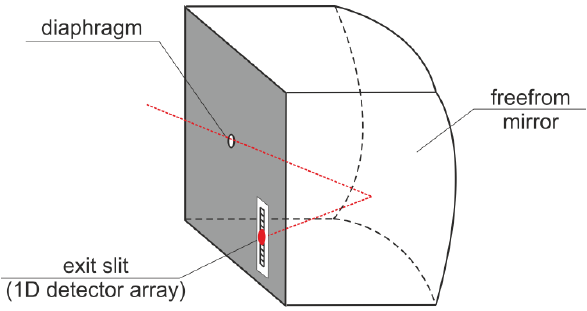
Figure 6. The proposed idea of a freeform mirror application in an AOI sensor.